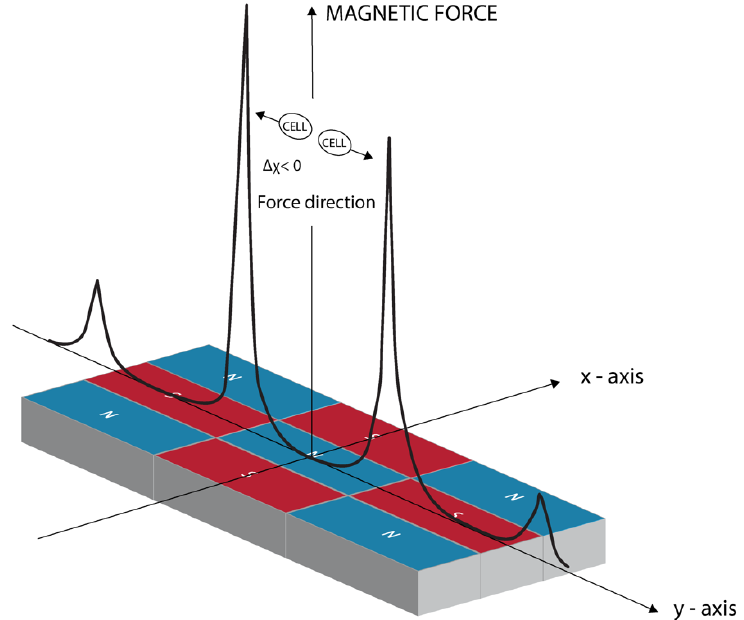
Figure 3. Magnetic field gradient created mechanical force direction. A calculated plot along the y -axis of the magnetic field-induced mechanical force, F z , component. For the case when the medium surrounding the cells is more diamagnetic than the cells (Dc < 0), cells are attracted to stronger and more nonuniform magnetic field areas as marked in this sketch.